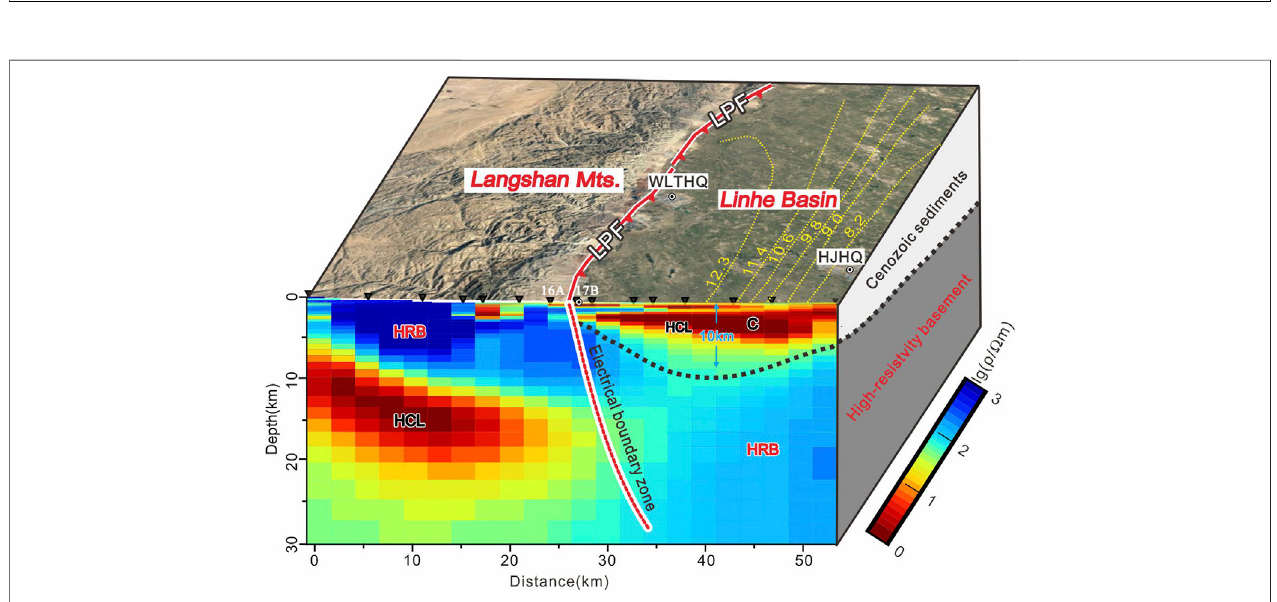
FIGURE6| ElectricalstructureandinterpretationmapofthecoreareaoftheLangshanMountain-LinheBasinarea(thelocationisshownintheblackdottedboxin Figure 1B ). The thickness of the Cenozoic sedimentary layer is quoted from the State Seismological Bureau (1988).